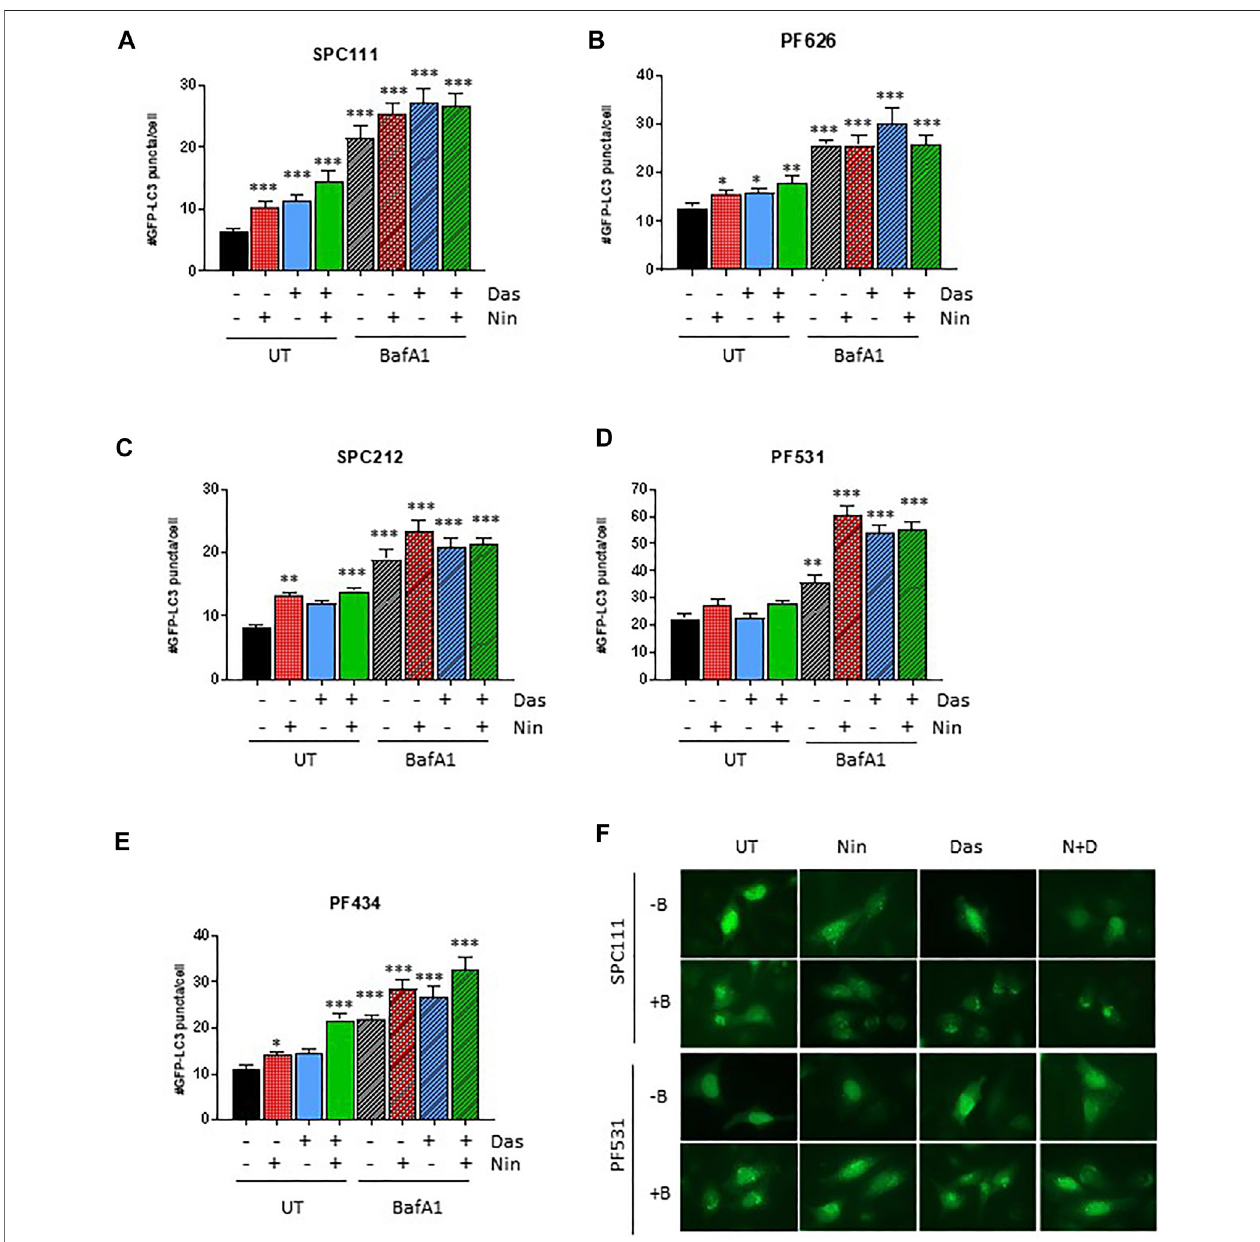
FIGURE5| Autophagosome formationinresponsetodasatiniband nintedanibisdependent onthe cellline (A – E) GFP-LC3 puncta formationwasquanti fi ed after treatment (Das: dasatinib 50 nM; Nin: nintedanib 1 μ M; 24 h; N + D, combination of nintedanib and dasatinib) with or without Ba fi lomycin A1 (Baf A1, 100 nM). Representative pictures are shown in (F) . Bars are average ±SEM of three independent experiments. *, p < 0.05; **, p < 0.01; ***, p < 0.001, n. s. , non-signi fi cant, t -test.